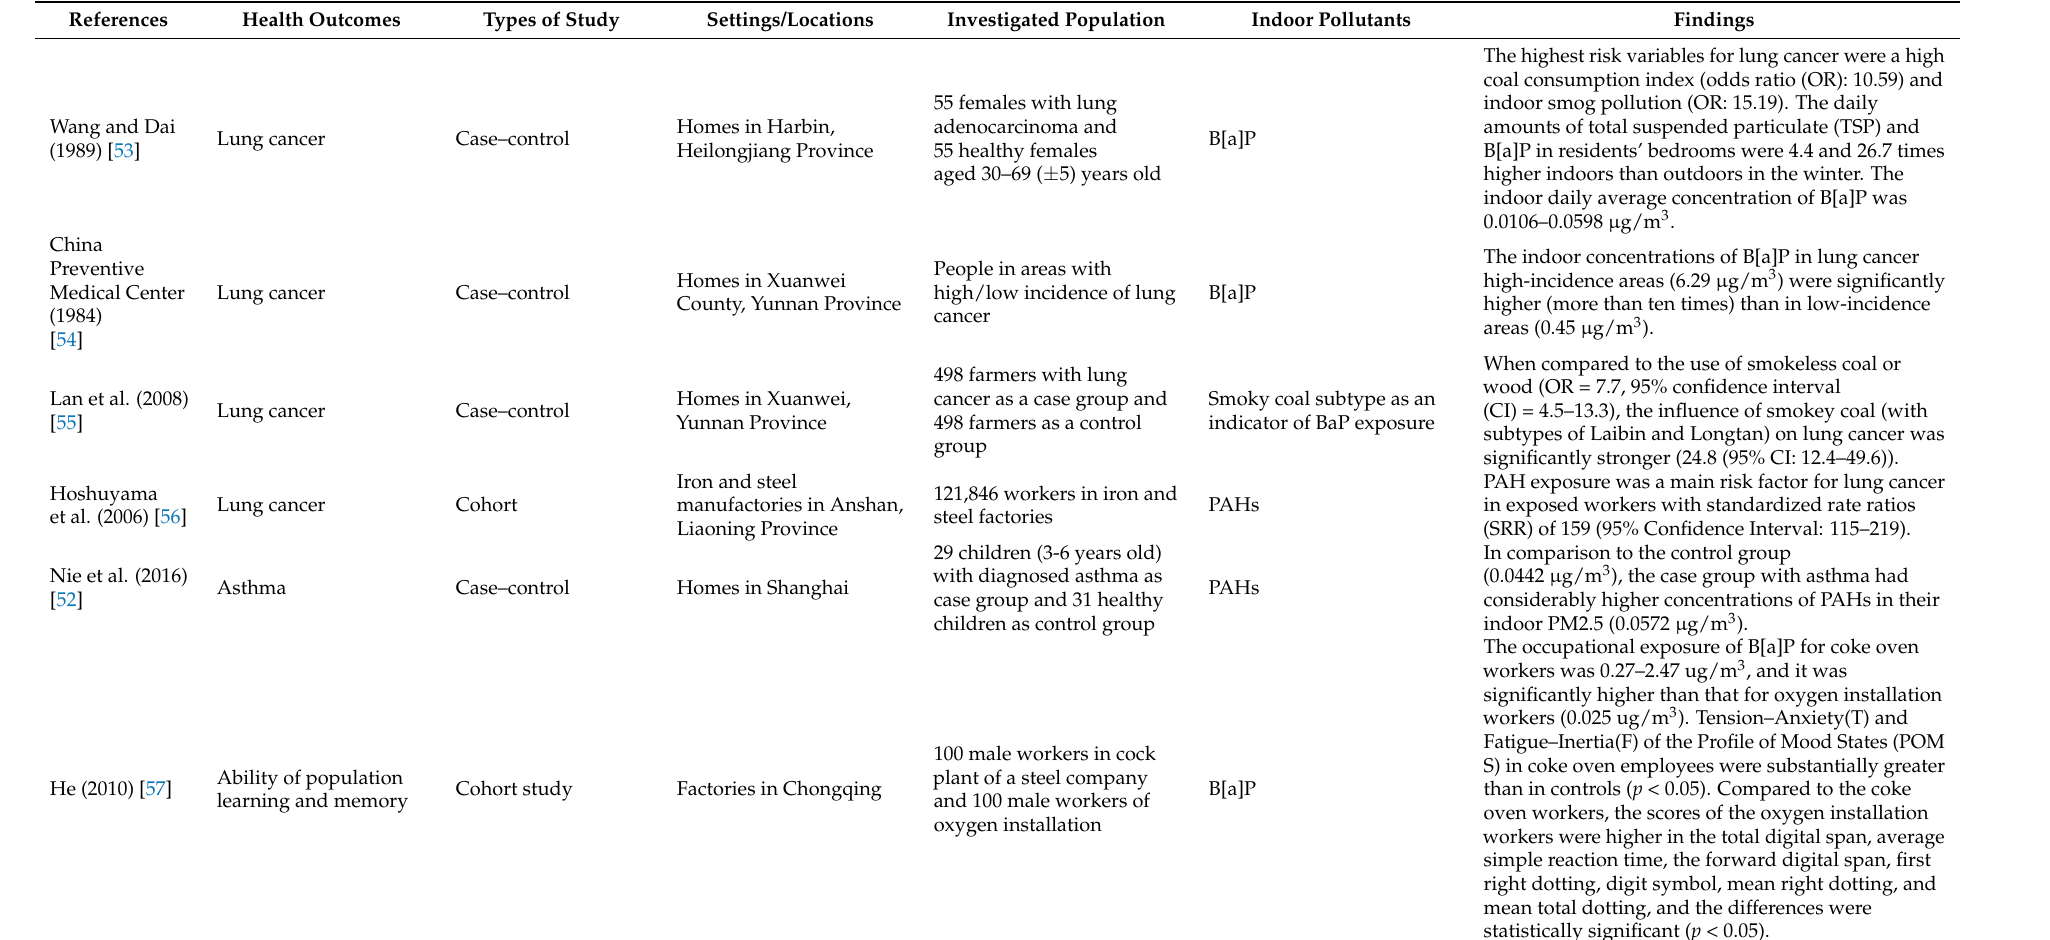
Table 1. Polycyclic aromatic (PAH) exposure and its associations with health